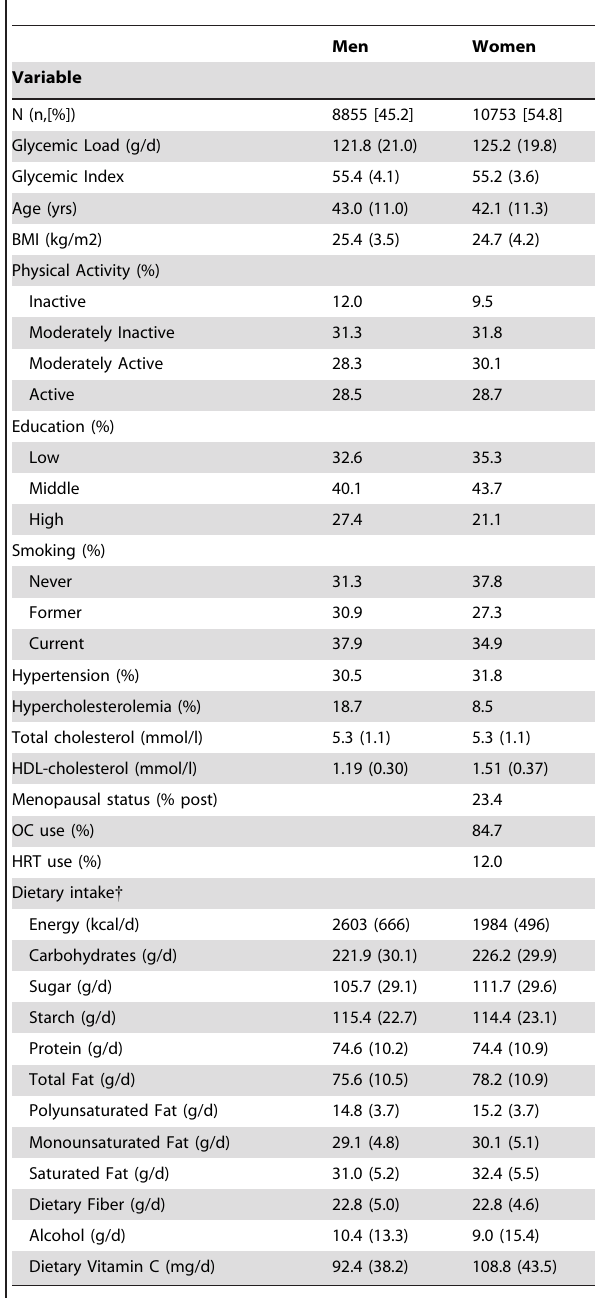
Table 1. Baseline Characteristics* of the EPIC-MORGEN cohort According to